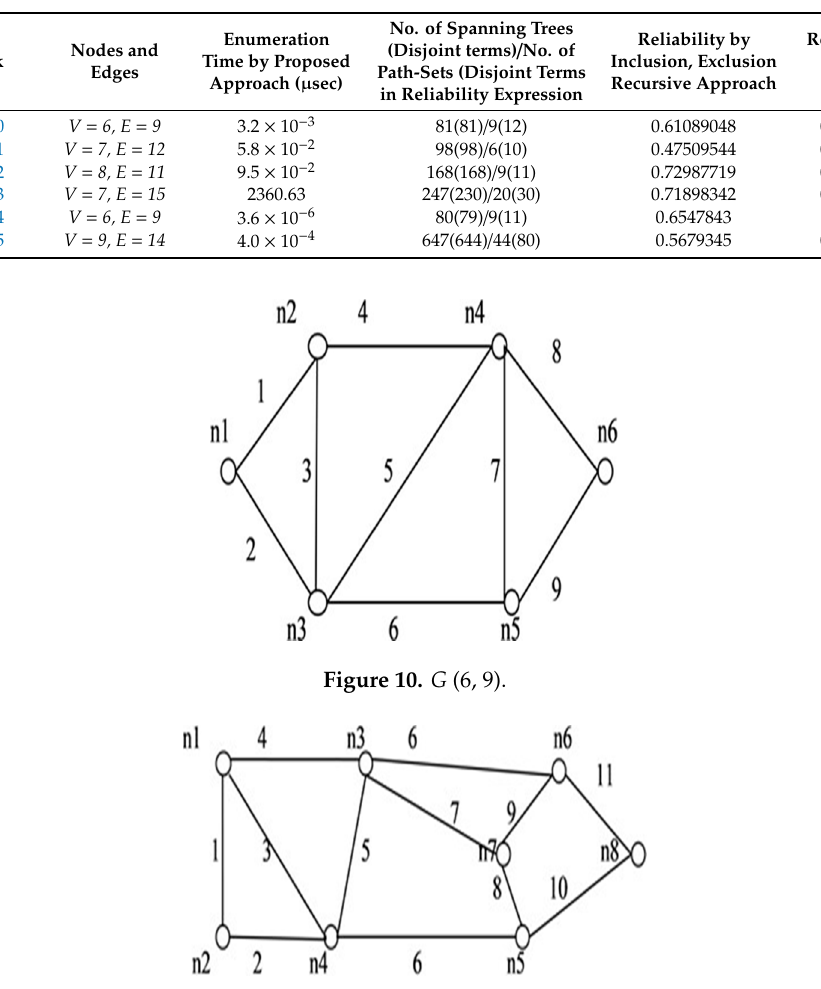
Figure 11. G (7, 12).